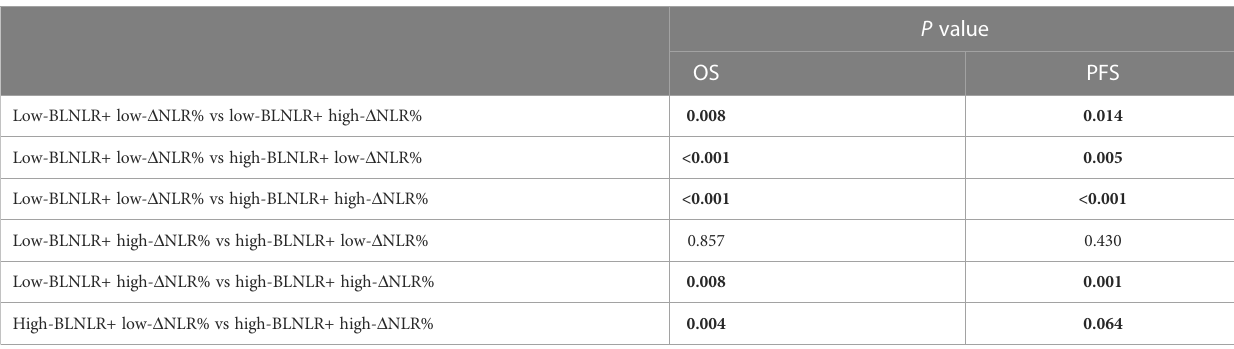
TABLE 4 Comparison between groups of Kaplan-Meier curves for low BLNLR+ low D NLR%, low BLNLR+ high D NLR%, high BLNLR+ low D NLR% and high BLNLR+ high D NLR%.